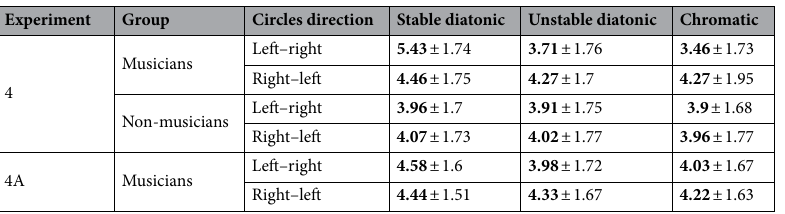
Table 2. Mean (in bold) ± SD of size matchings in Experiments 4 and 4A as a function of musical experience group (musicians/non-musicians) and circles’ direction (large circle to small circle from right to left, or from left to